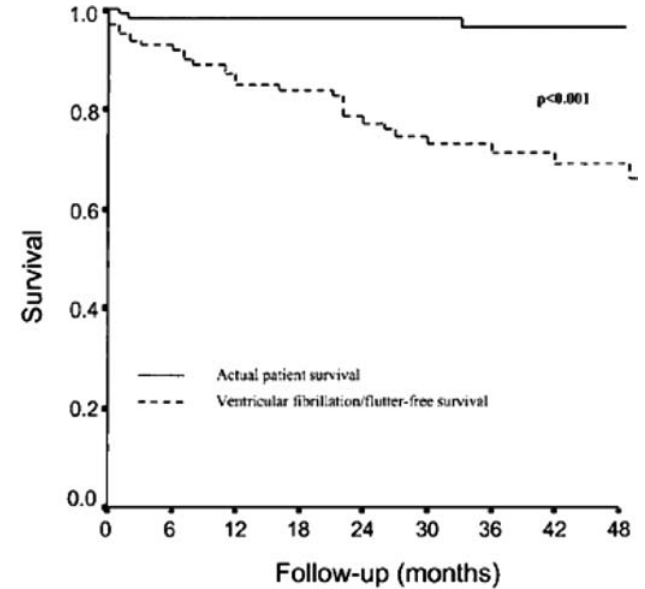
sudden death in patients with arrhythmogenic right ventricular cardiomyopathy/dysplasia. Circulation 108, 3084-91 (2003).